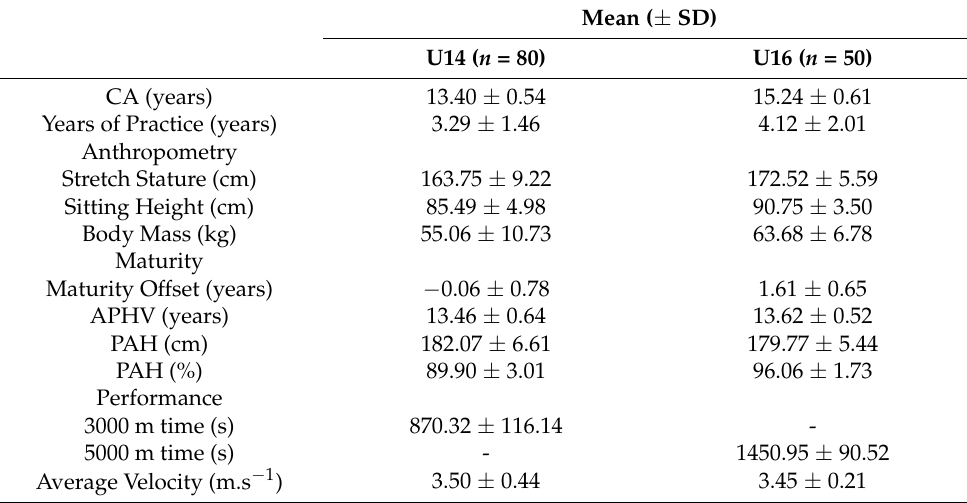
Table 1. Mean values ( ± SD) of chronological age (CA), years of practice, anthropometry, maturity, and performance parameters in U14 and U16